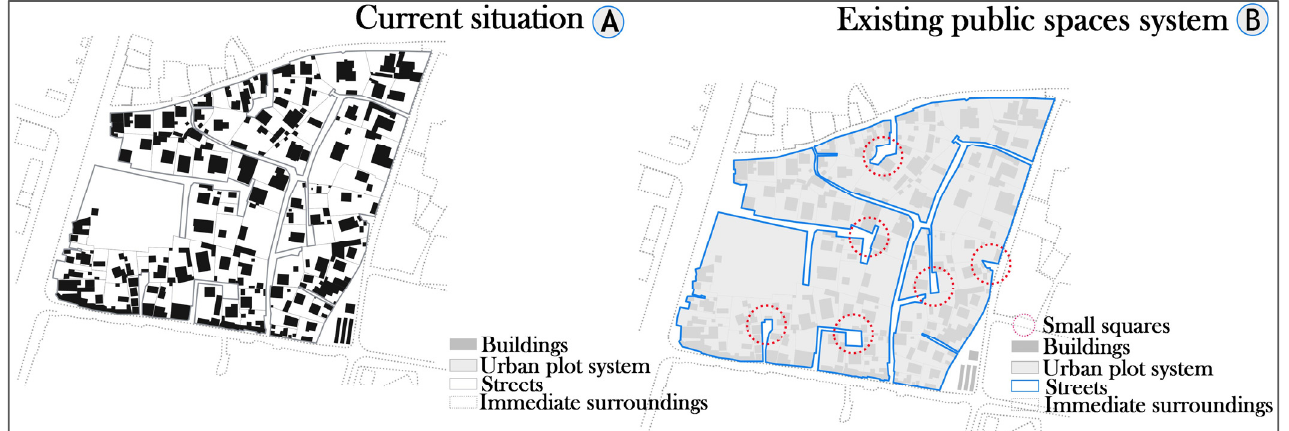
Figure 10. Current situation of Block 33.